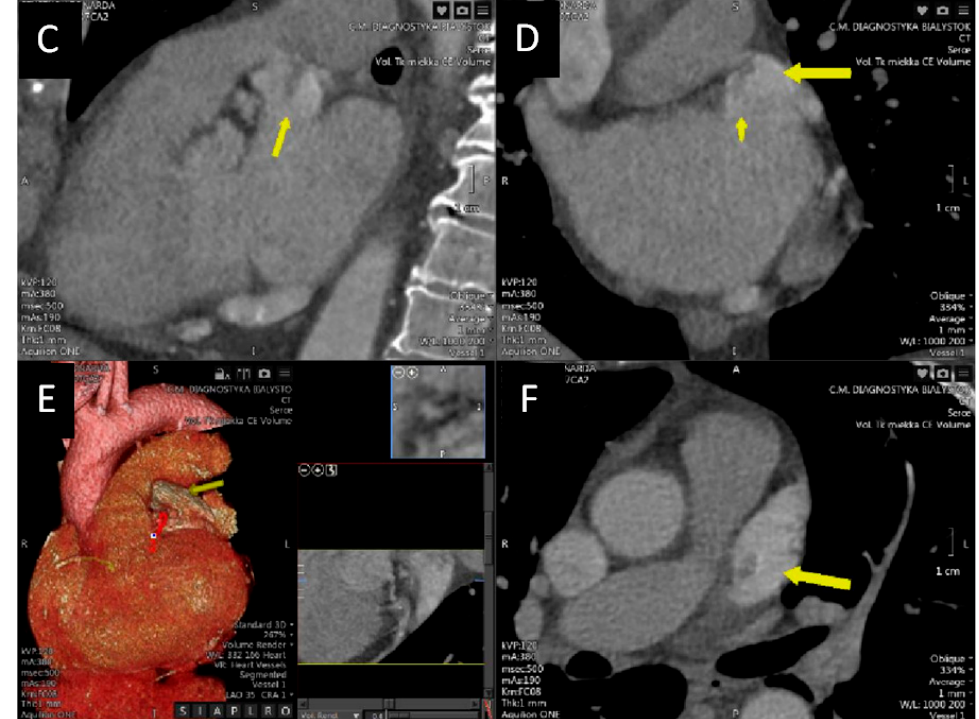
Figure 1. A 75-year-old female patient with permanent atrial fibrillation undergoing apixaban therapy, with a suspicion of a tumor in the left atrium, was admitted to the Clinic for further diagnosis. Transthoracic echocardiography showed good valve function and mildly impaired global left ventricular systolic function with an ejection fraction estimated at 50%. In a transesophageal echocardiographic examination in the left atrial appendage, 17 × 9 mm balloting masses were additionally visible, attached to its wall from the side of the pulmonary trunk ( A , B ). Computed tomography was performed, which describes the hypodense soft tissue formation adjacent to the upper wall of the left atrium, 14 × 16 mm with a wide base of 11 mm, and attached to the upper wall of the ear ( C – F ). The structure showed mobility consistent with that of the left atrium. Due to the morphological image of the formation (low density and irregular shape) and the possibility of a myxoma-like focal change, the patient was consulted by the Heart Team. Due to the ambiguous nature of the lesion (thrombus vs. myxoma), apixaban was changed to warfarin and qualified for MRI after 3 months. The examination was performed and there was no evidence of any mass in the left atrium, which confirmed that the found structure was a thrombus. The most common nodular changes in the heart are metastatic tumors of lung cancer, breast cancer and hematological neoplasms. Primary tumors are much rarer and are benign in 75% of cases (e.g., myxoma, fibroma, lipoma). Malignant neoplasms, mainly sarcomas and lymphomas, constitute 25% of primary tumors. Apart from proliferative changes in the heart, there are also non-neoplastic structures such as thrombus, vegetation or inflammatory tumors [1,2]. Echocardiography is the primary test used to diagnose additional masses in the heart due to its wide availability. Transthoracic echocardiography (TTE) allows for the assessment of the size, location and mobility of the mass. Transesophageal echocardiography (TEE) is especially valuable for assessing lesions located in the left atrium. Often, echocardiography enables the initial differentiation of myxoma from thrombus based on differences in tissue perfusion [3,4]. However, in some patients, more accurate imaging techniques, such as computed tomography or magnetic resonance imaging, are necessary in the differential diagnosis [5–7].